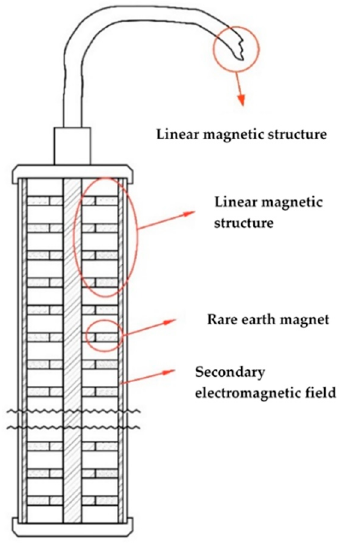
Figure 1. Multivector field